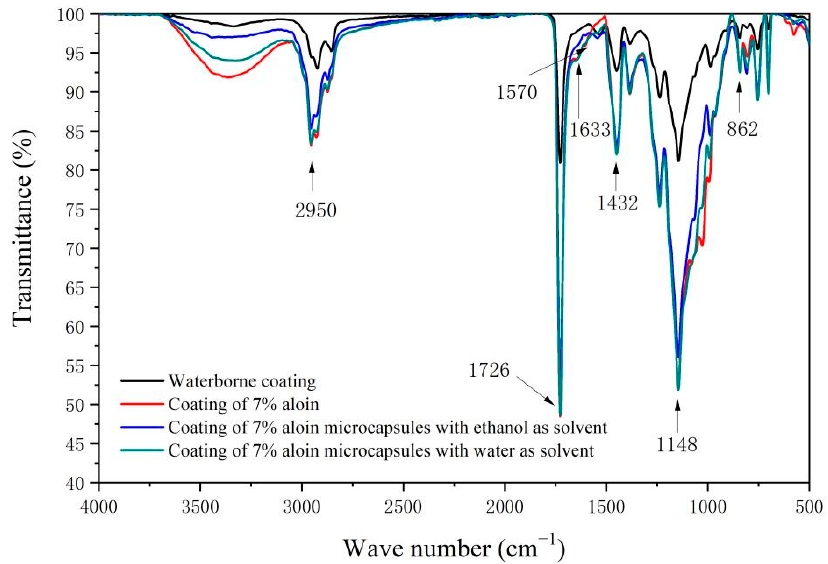
Figure 9. Infrared spectra of waterborne coating, coating with 7.0% aloin, coating with 7.0% aloin microcapsules prepared with ethanol as the solvent, and coating with 7.0% aloin microcapsules prepared with water as the solvent.